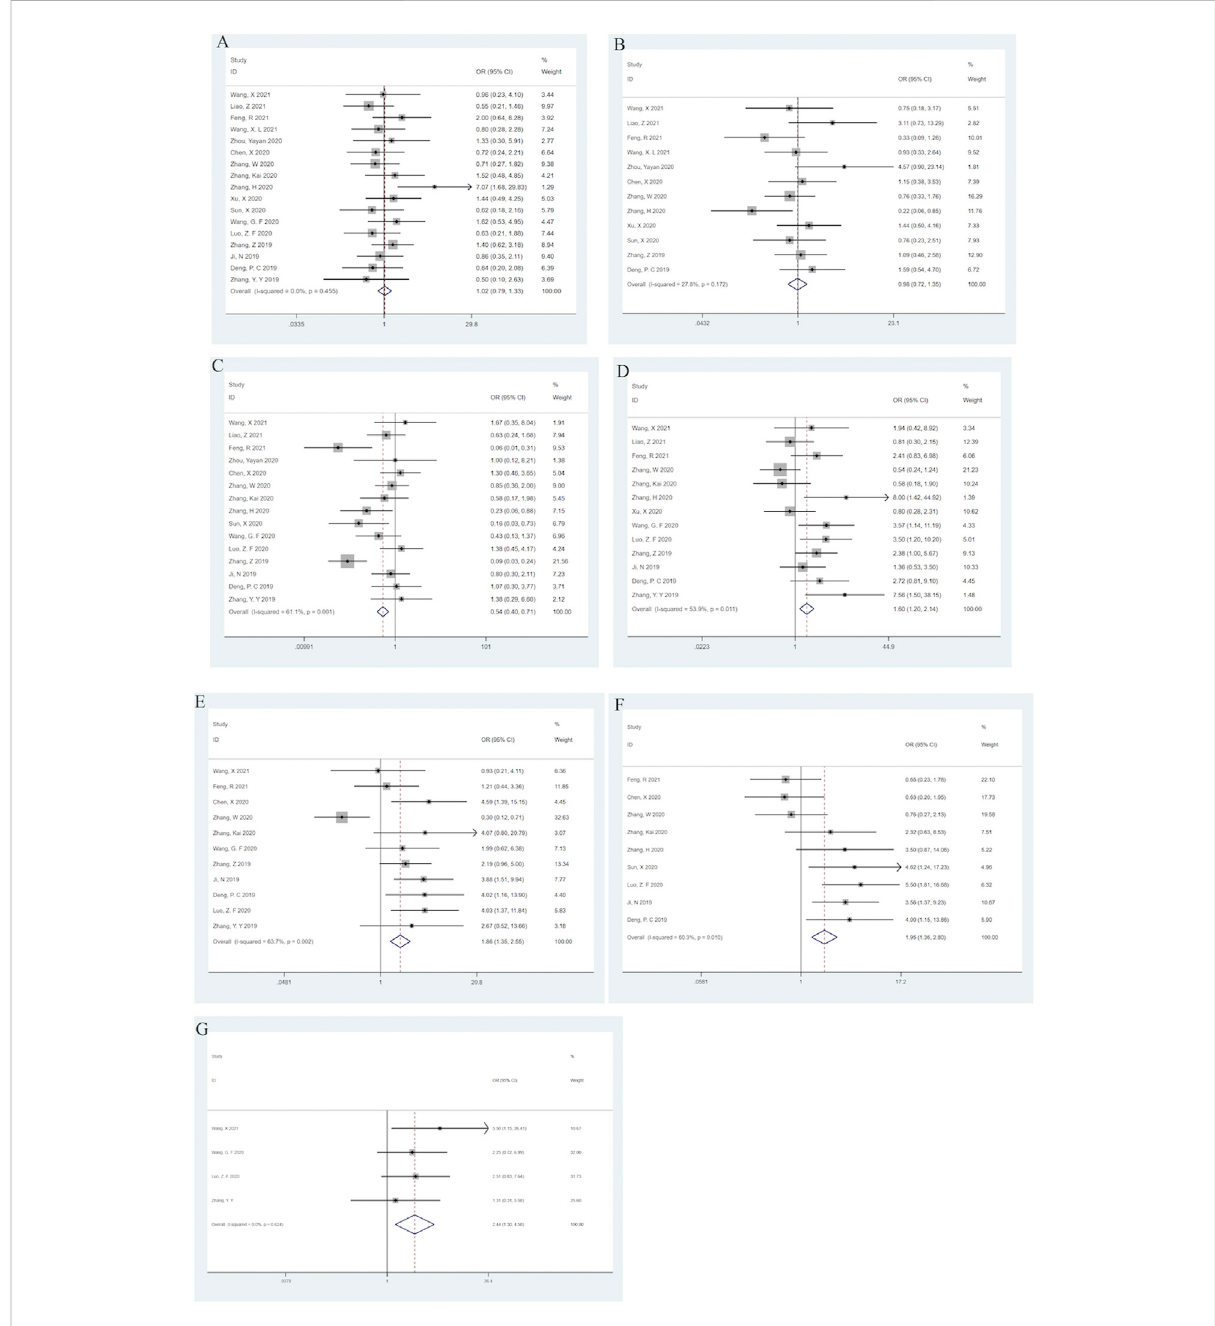
FIGURE 3 Forest plots for association of SNHG14 expression with clinicopathological features: Age (A) , Gender (B) , TNM staging (C) , Tumor size (D) , Lymph node metastasis (E) , Differentiation grade (F) , Distant metastasis (G) .